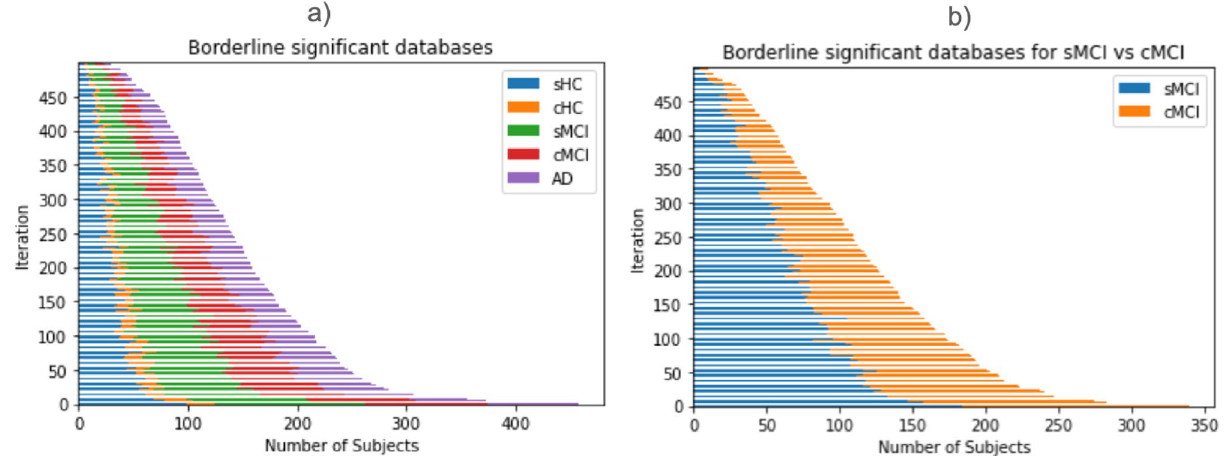
Figure 2. Distribution of subjects within each group for all the obtained databases ( a ) minimum N simulation across five clinical groups ( b ) minimum N simulation across MCI